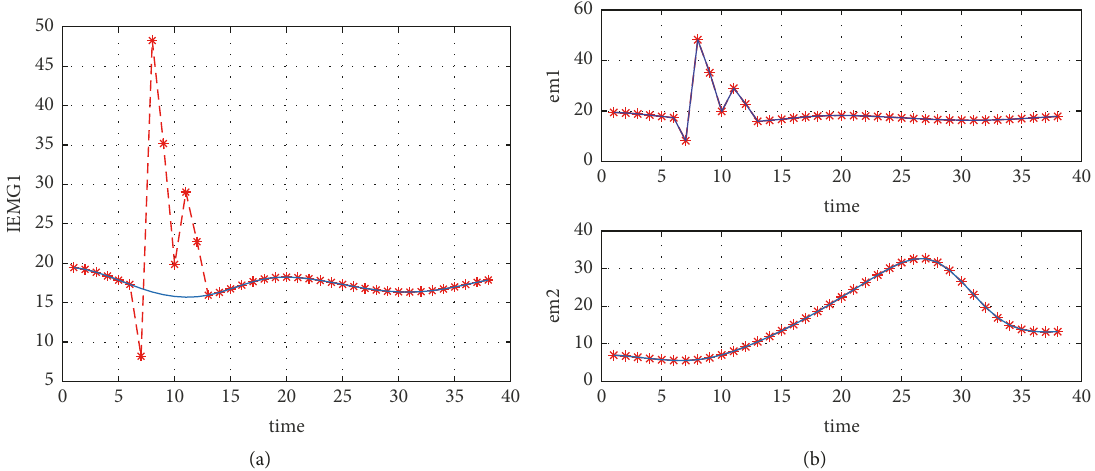
Figure 12: Random fault in IEMG1 signal. (a) Healthy and faulty IEMG1 signal. (b) Real and estimated faulty input.